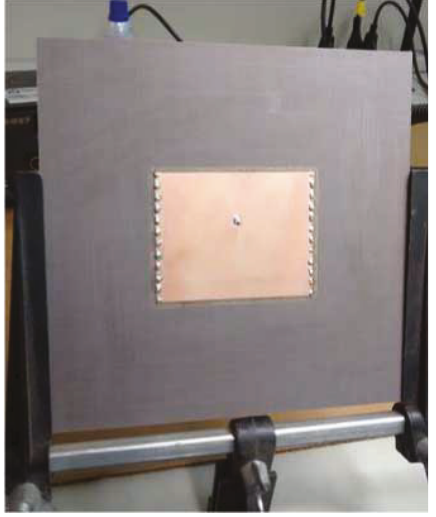
Figure 21: SIW antenna prototype.